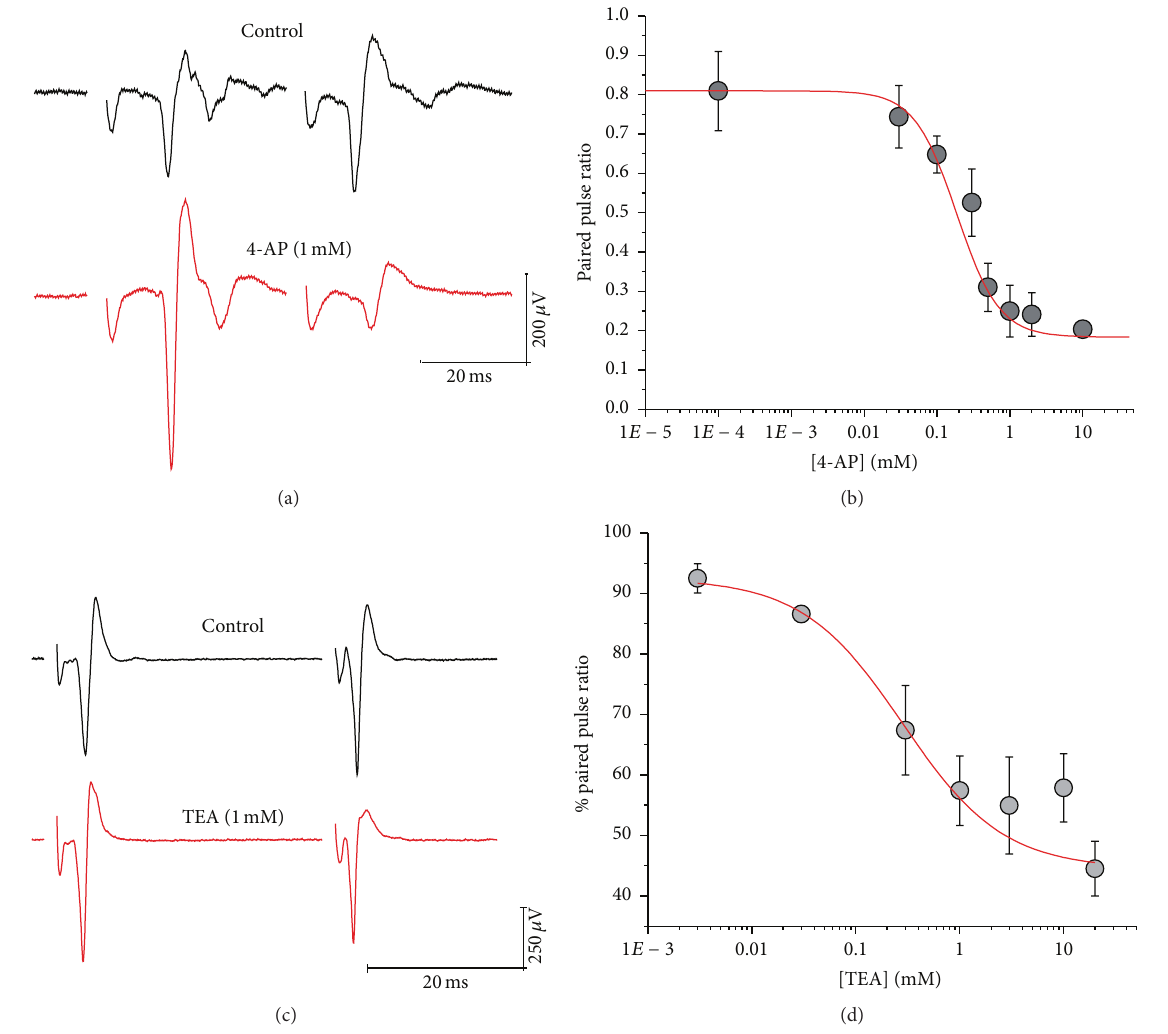
Figure 1: Nonspecific potassium blockers reveal the presence of presynaptic potassium channels at corticostriatal synapses. (a) Exposure to 4-AP (1mM) causes an increase in the amplitude of the first synaptic response decreasing PPF. Representative traces recorded from the same slice before (upper trace) and after (lower trace) exposure to 4-AP are shown. (c) A similar effect was observed when applying TEA (1mM). In both cases, paired-pulse facilitation reduction was dependent of the concentration used. (d) and (b), Dose-response relation for TEA and 4-AP,